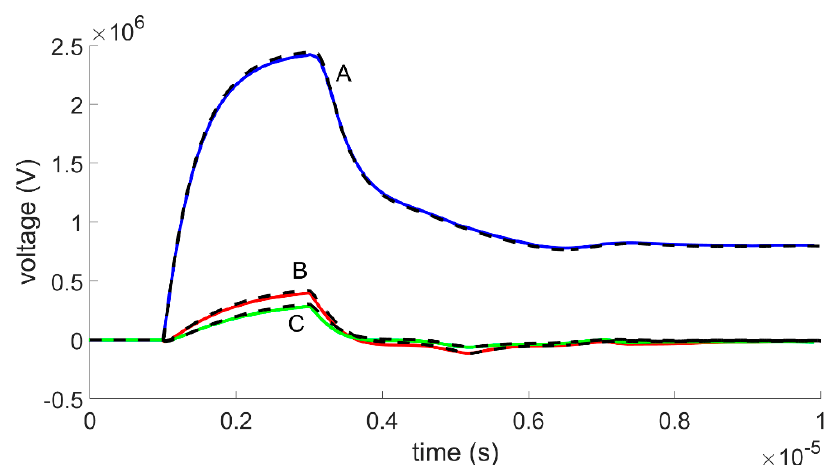
Figure 15. Voltage comparison between the results from the proposed method (solid lines) and those obtained from ATP simulations (dashed lines) for example 3.3. The comparisons were made at the middle point of the line (300 m from the sending node) for phases A, B, and C.